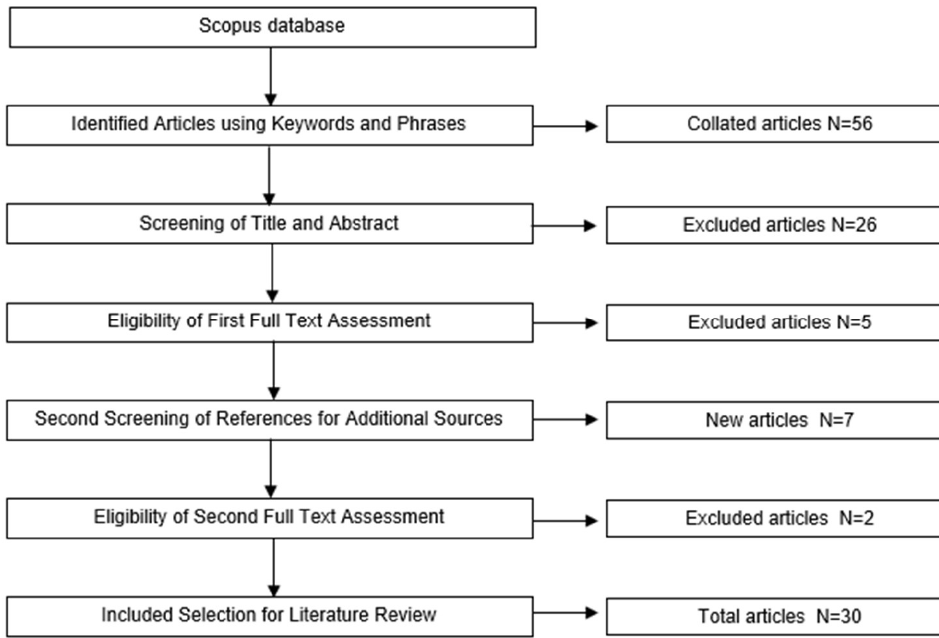
Figure 2. Method of final study sample for the literature review.